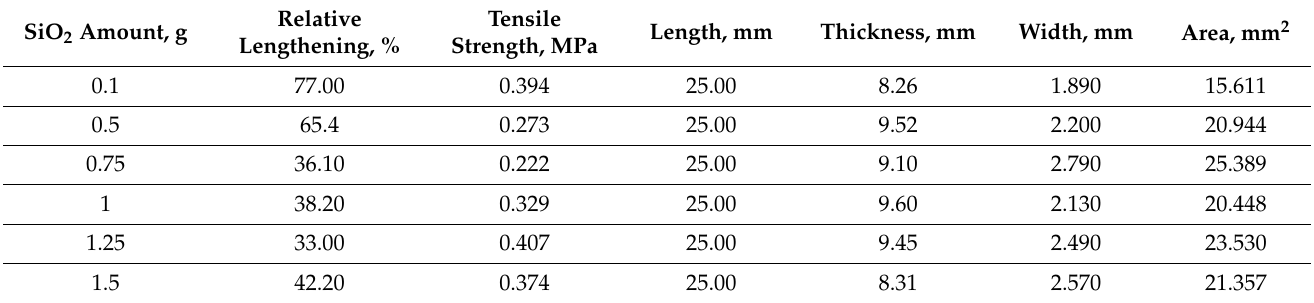
Table 1. The results of mechanical tests of BIN composite samples.